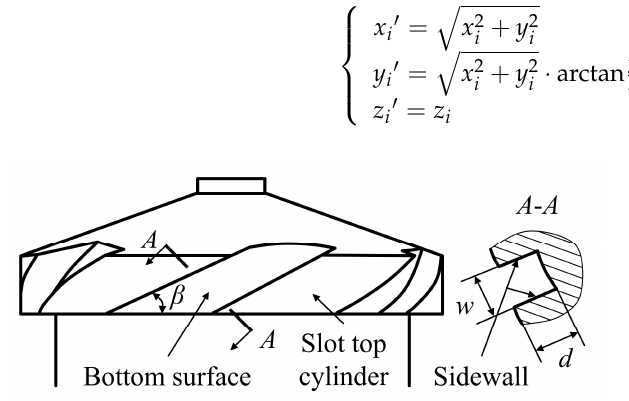
Figure 7. Swirl slot of the inner part of the nozzle.